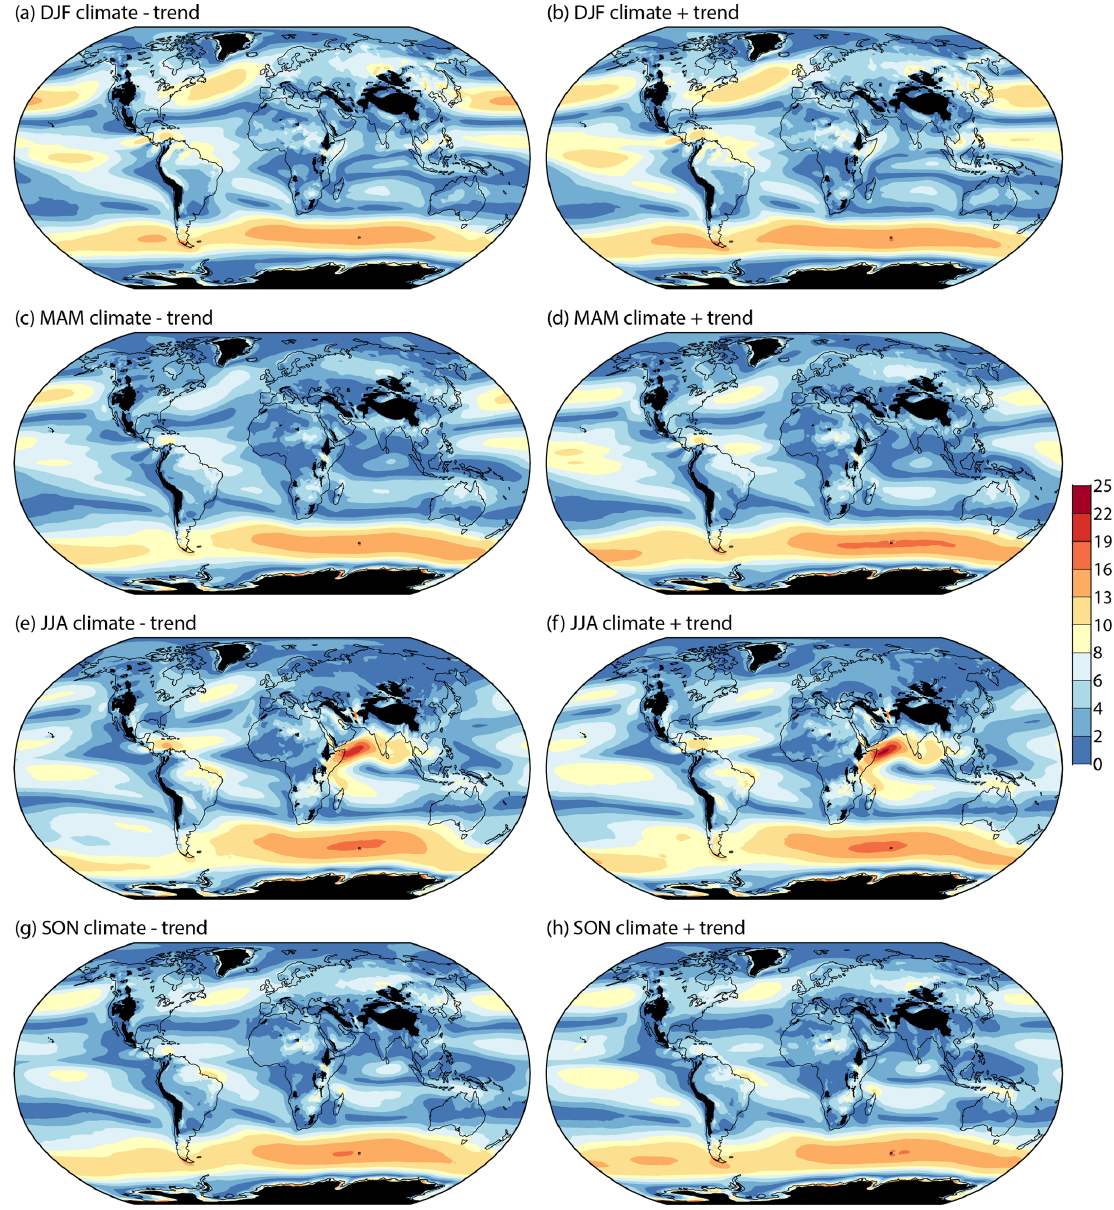
Figure 18. Seasonal 850hPa wind speeds (ms − 1 ) based on subtracting (left) and adding (right) the 21.5-year change derived from least squares linear fits of seasonal-mean wind components for March 1979 to February 2022 to the average wind components for the period, shown for (a, b) DJF, (c, d) MAM, (e, f) JJA and (g, h) SON. Regions where the ERA5 model orography exceeds 1500m are masked in